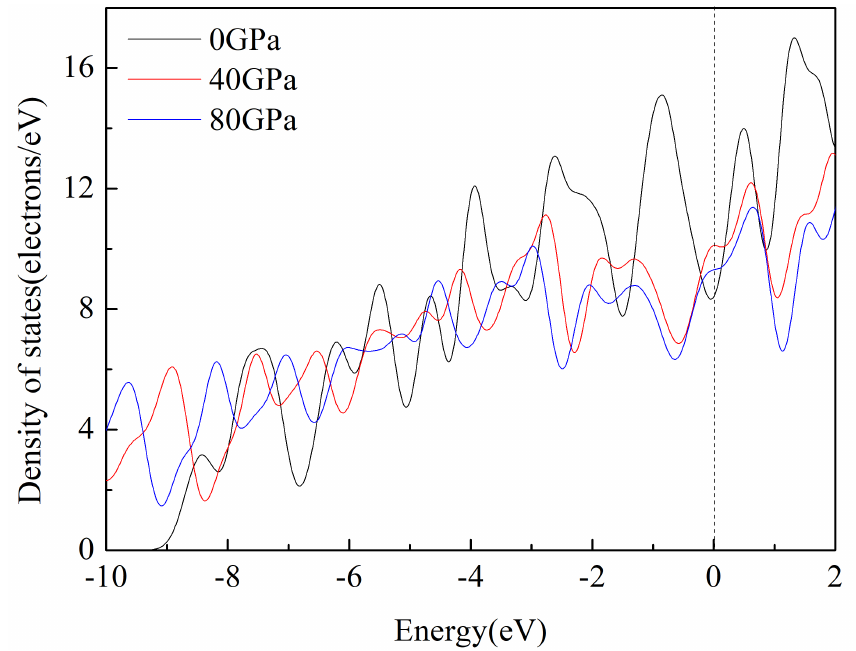
Figure 11. The density of states for β -Mg 17 Al 12 under different